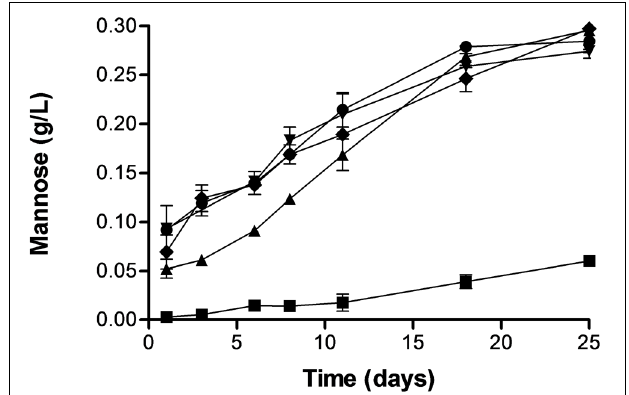
FIGURE 5 | Release of mannose from S. cerevisiae cells untreated and treated by PEF treatments of different intensity. Untreated ( (cid:4) ), 15 kV/cm 45 µ s ( (cid:78) ), 15 kV/cm 150 µ s ( (cid:72) ), 25 kV/cm 45 µ s ( (cid:7) ), 25 kV/cm 150 µ s ( •